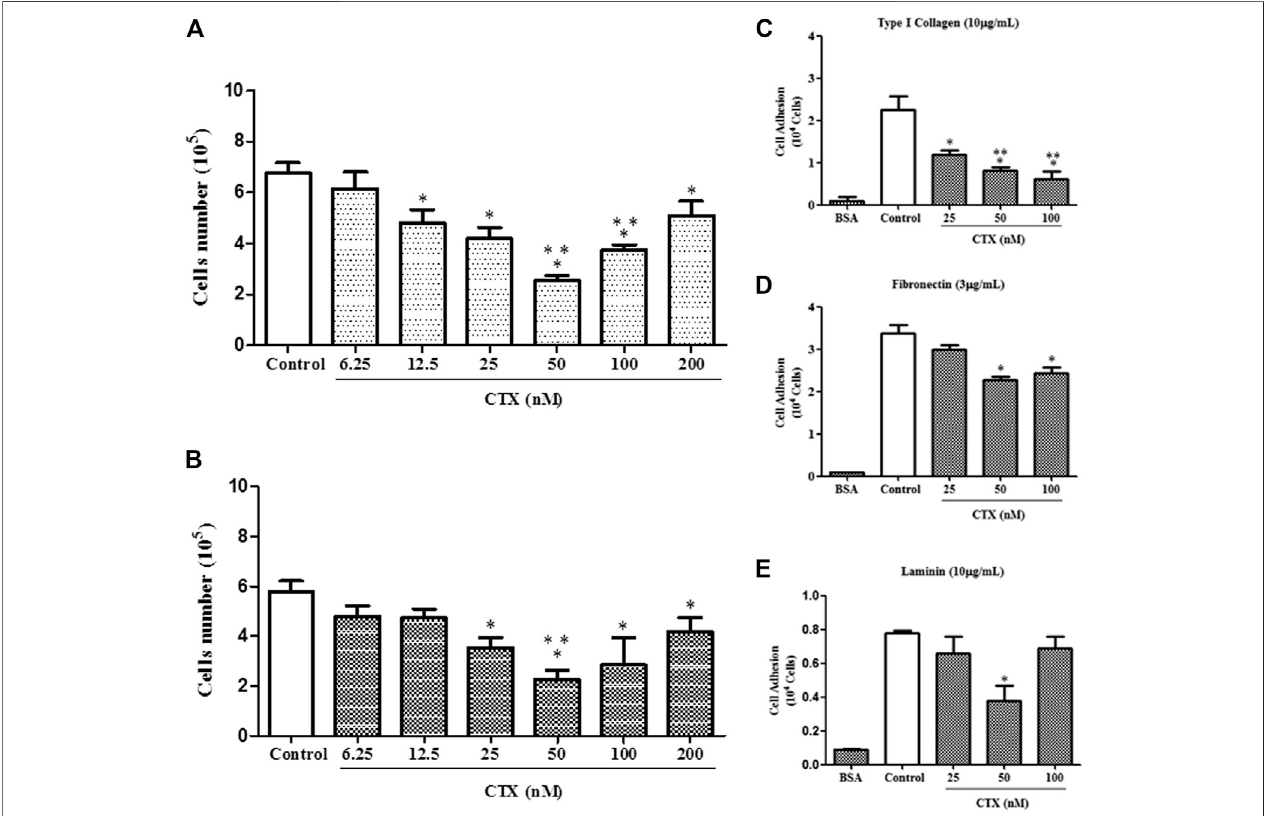
FIGURE1| EffectofCTXont.End.1cellproliferationandadhesiontoextracellularmatrixligands.t.End.1cells(5 × 10 4 cells/well)wereincubatedinthepresenceof different CTX concentrations (6.25, 12.5, 25, 50, 100 and 200 nM) for 24 h (A) or were previously incubated with the different concentrations for only 1 h and then washed and incubated for another 24 h only in fresh culture medium (B) . Cell proliferation was assessed after 24 h by cell counting. The data are presented from three distinct experiments run in octoplicate and are expressed as mean ± s.e.m. * p < 0.05 compared to control group, ** p < 0.05 compared to other CTX concentrations. For adhesion assay, t.End.1 cells pretreated for 1 h with CTX (25, 50 and 100 nM) were washed and added (100 µl) to Maxsorp plates (Nunc ® ) containing 96 wells, previously sensitized with the different ligands of matrix: type I collagen (10 µg/ml) (C) ; fi bronectin (3 µg/ml) (D) and laminin (10 µg/ml) (E) . After 1 h, adheredcellswereevaluatedbyMTTassay.Thevaluesobtained werefedintoGraphPadINSTATprogramV2.01forconversion ofopticaldensity (OD)inthenumberof adheredcells.Thedataarepresented fromthreedistinct experimentsruninsextuplicateand areexpressed asmean ± s.e.m.* p < 0.05,compared tocontrolgroupand ** p < 0.01, signi fi cantly different from mean values for groups to their respective CTX-treated cells.